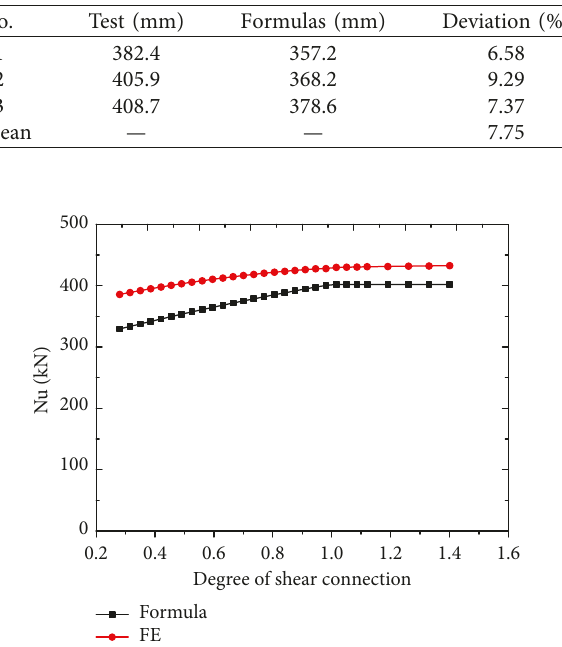
Figure 23: Sketches of the composite-truss partial connection stiffness.